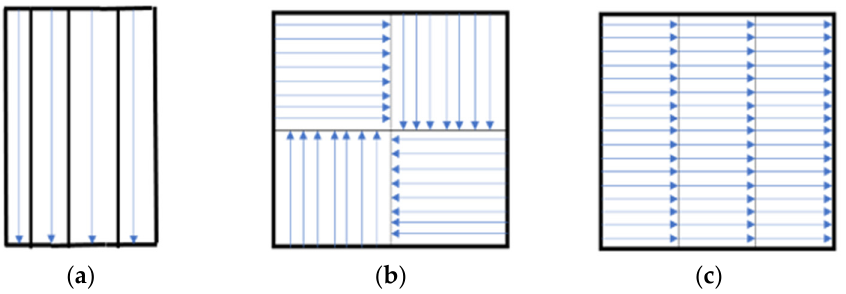
Figure 2. Existing strategies of handling anisotropy created by longitudinal filament, ( a ) adaptive toolpath width [18], ( b ) island toolpath strategy [19], ( c ) hatch parallel toolpath strategy [19].